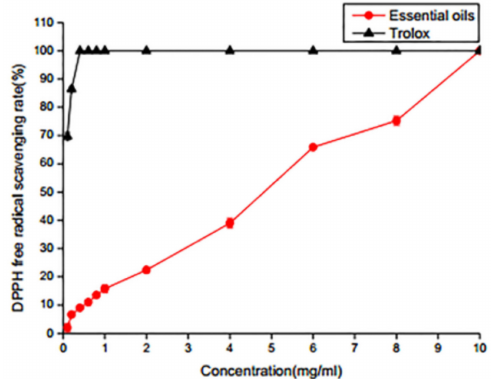
Figure 2. DPPH radical scavenging activity.